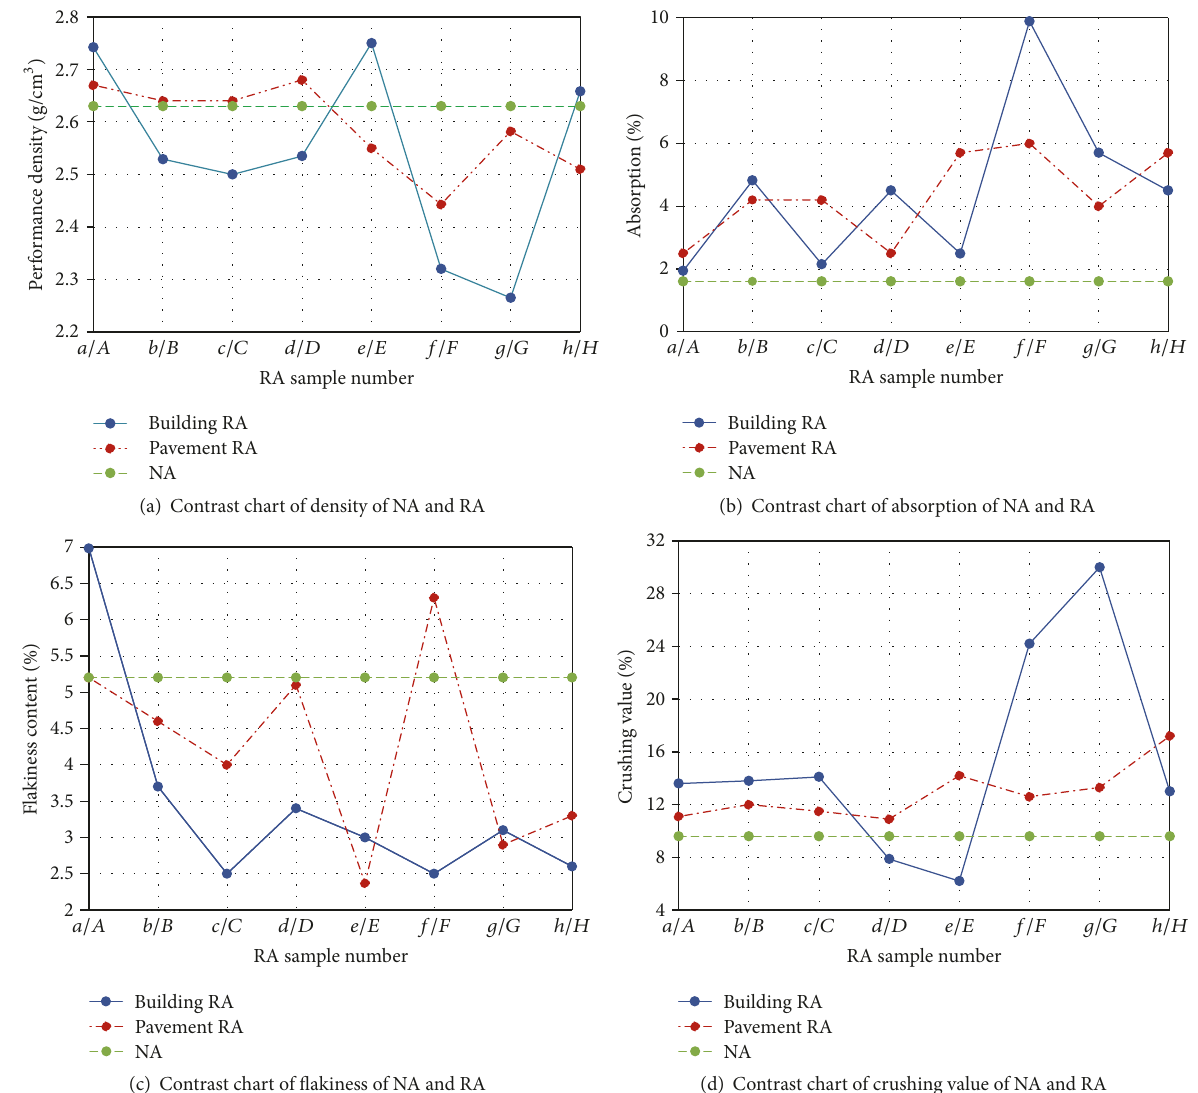
Figure 4: Contrast charts of NA and RA